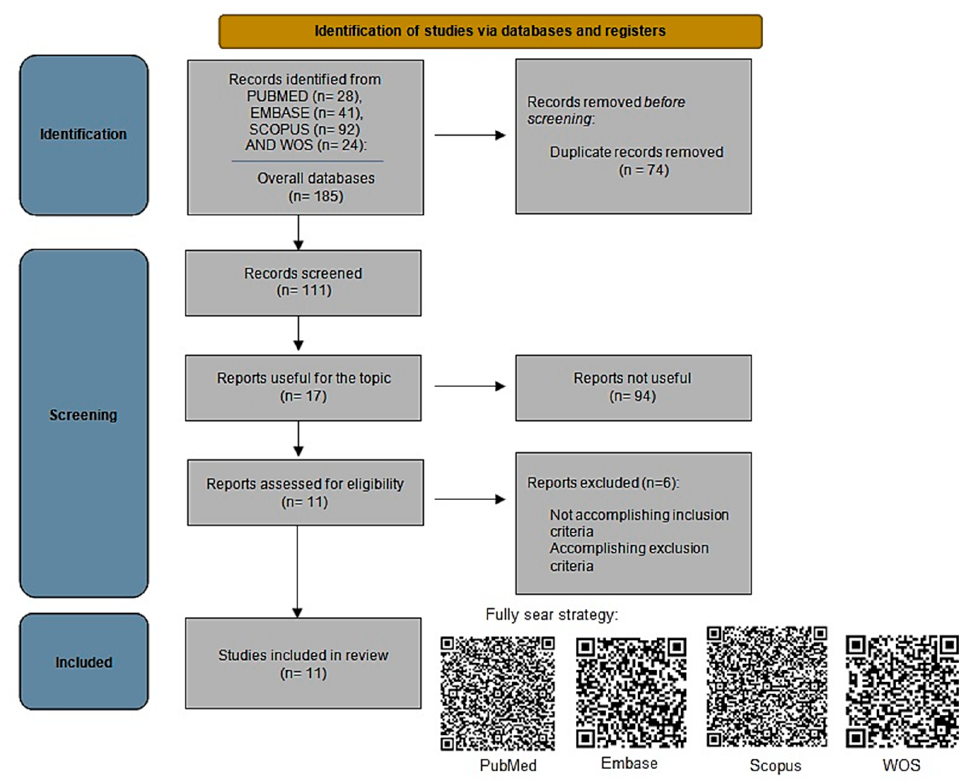
Figure 1. Flow chart following the PRISMA guide [23].